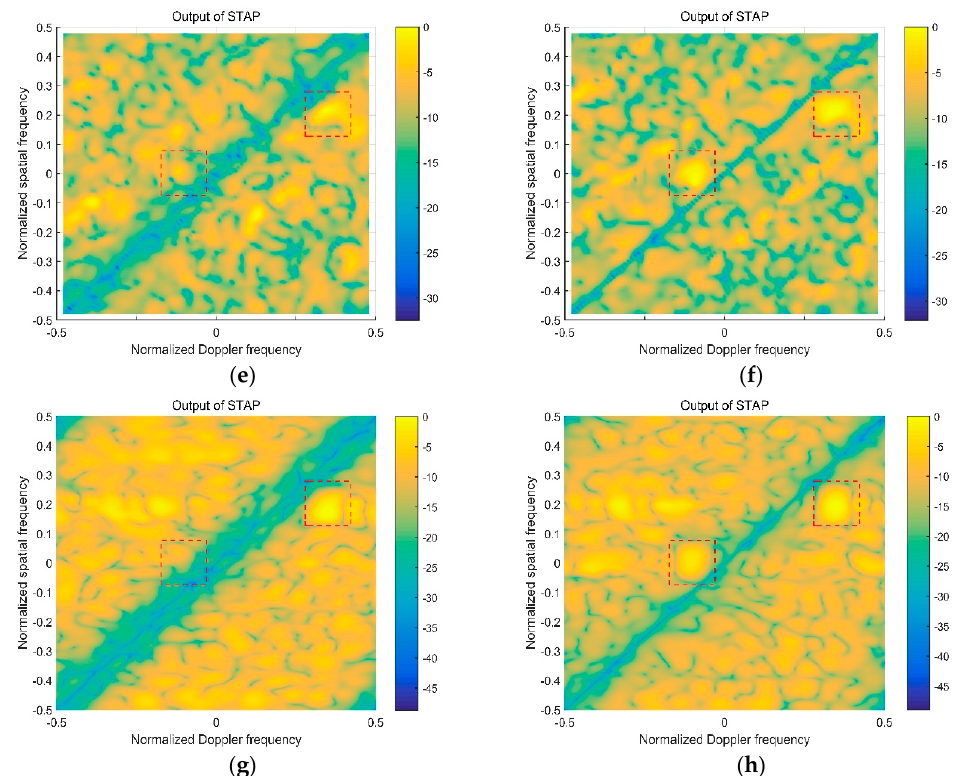
Figure 5. Comparison of target detection performance: ( a ) Full STAP before equalization; ( b ) full STAP after equalization; ( c ) AEP-STAP before equalization; ( d ) AEP-STAP after equalization; ( e ) JDL-STAP before equalization; ( f ) JDL-STAP after equalization; ( g ) 3DT-STAP before equalization; ( h ) 3DT-STAP after equalization.